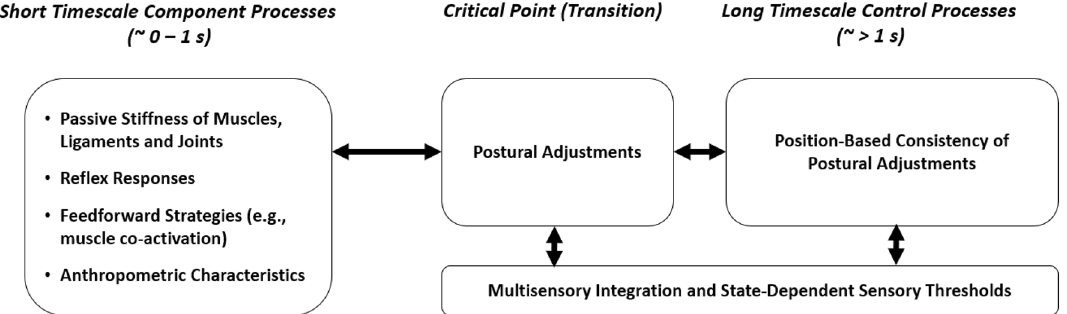
Figure 4. Component processes of postural control acting at different